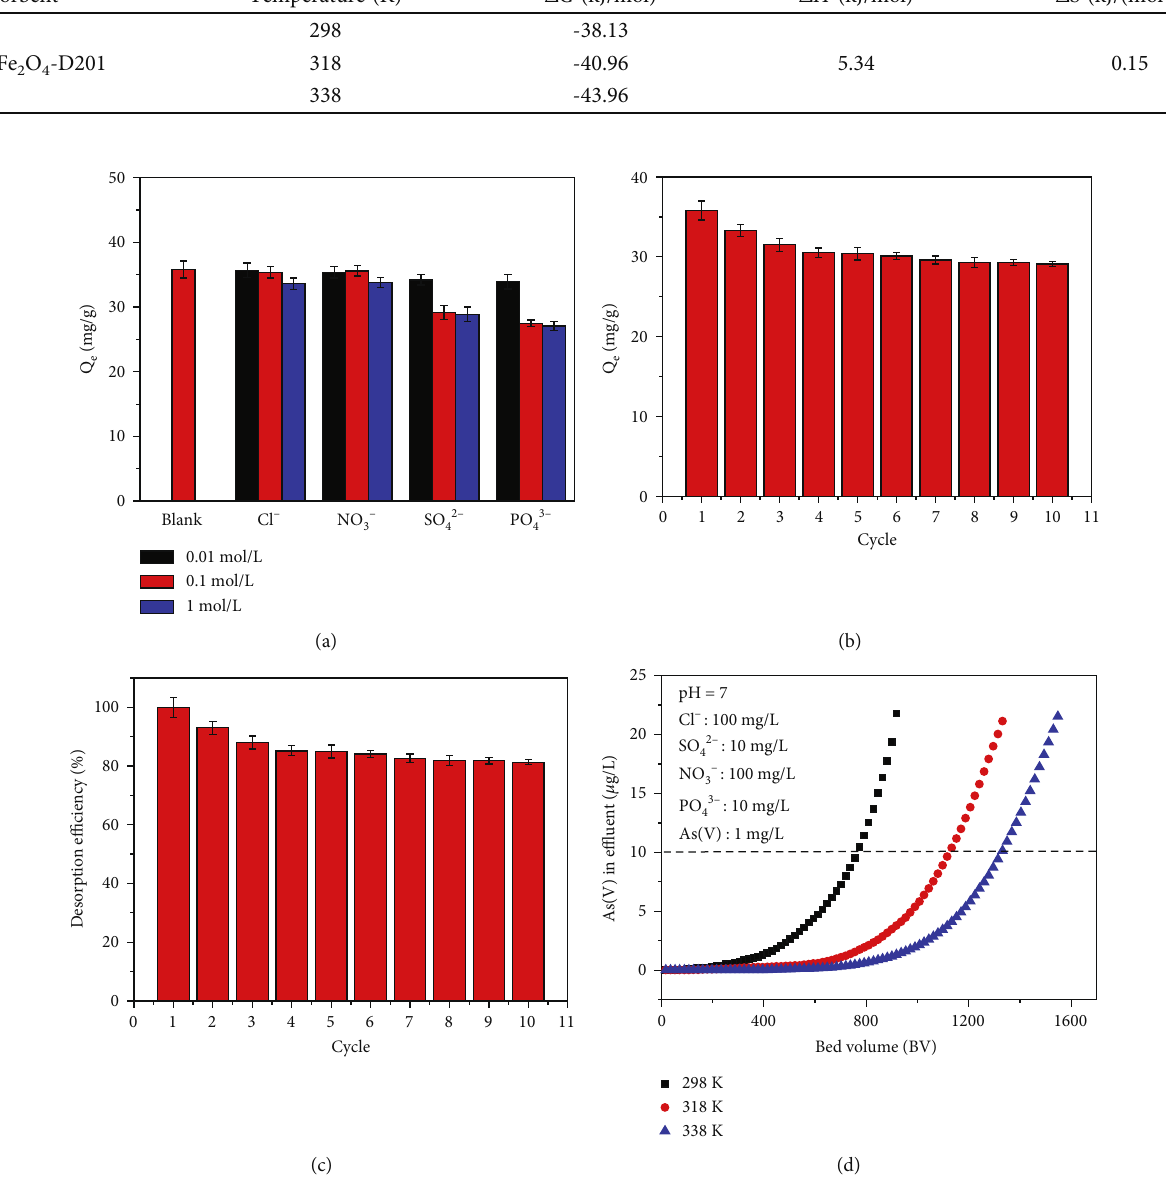
Figure 6: E ff ects of coexistent ions and ionic strength on As(V) adsorption (a). Adsorption-desorption experiments of As(V) for MnFe D201 on adsorption capacity (b) and desorption e ffi ciency (c). Fixed-bed column experiment with simulated wastewater e ffl uent (d) (the uniform experimental condition: 100 mL of 30 mg/L As(V) with 50mg MnFe concentration on 0.01 M, 0.1 M, and 1M; (b, c) 50mL of 0.1mol/L NaOH solution for 3 h; (d) the solution fl ow rate at 2 mL/min, 1mg/ L As(V), 10mg/L SO 42- , 100 mg/L Cl - , 10mg/L PO 43- , and 100 mg/L NO 3- , at 298 K, 318K, and 338